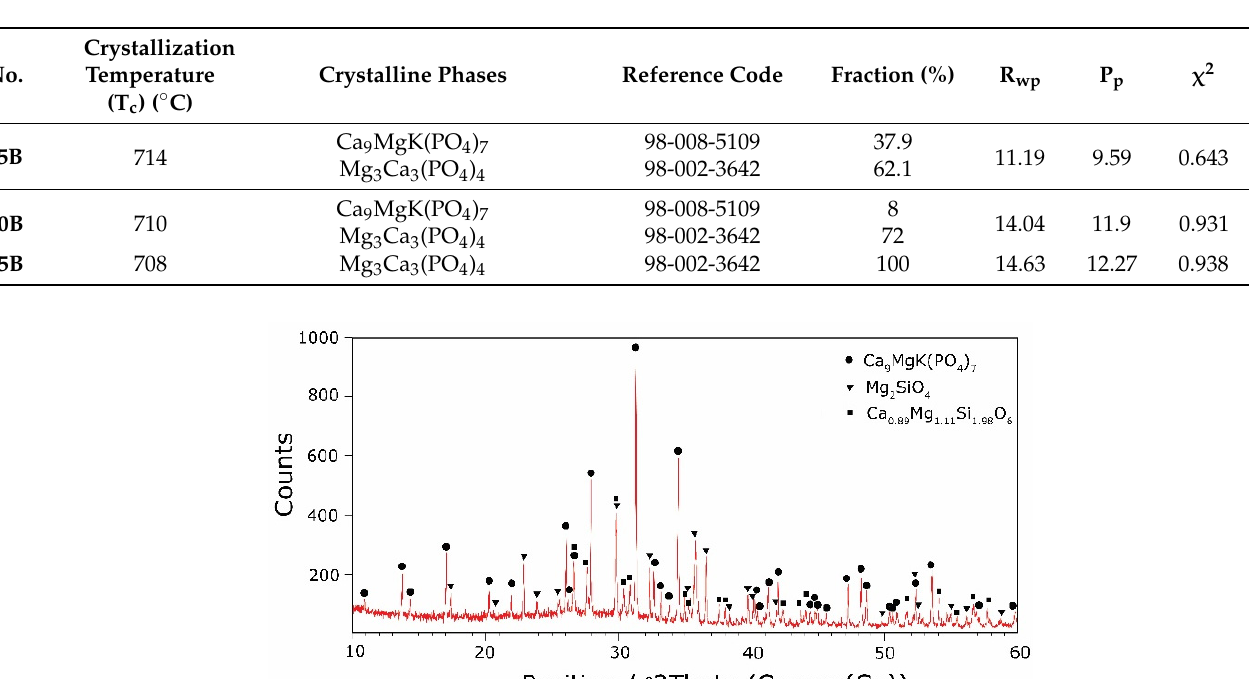
Figure 7. XRD patterns of 25B devitrificate obtained after isothermal heating at 708 °C (no 25B_708).